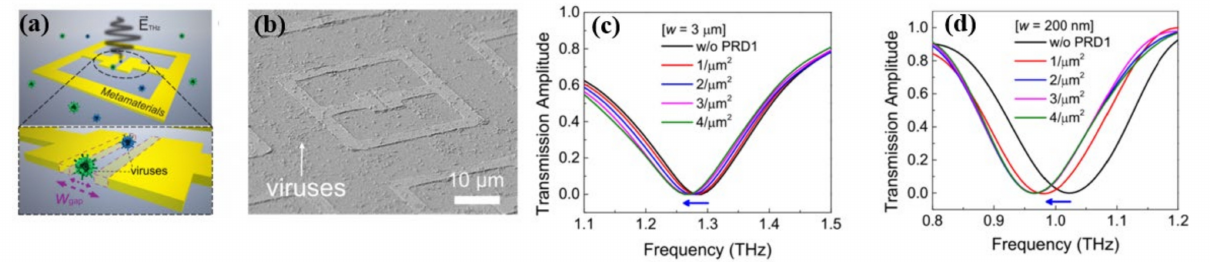
Figure 4. ( a ) Diagram of virus detection with THz nano-gap metamaterial. ( b ) Image (SEM) of viruses (width of gap 200 nm) and THz transmission amplitudes (normalized) of THz metamaterials with deposited PRD1 of different surface densities for gap width of ( c ) w = 3 µ m ( d ) w = 200 nm. Reprinted with permission from [42]. Copyright 2019 The Optical Society.